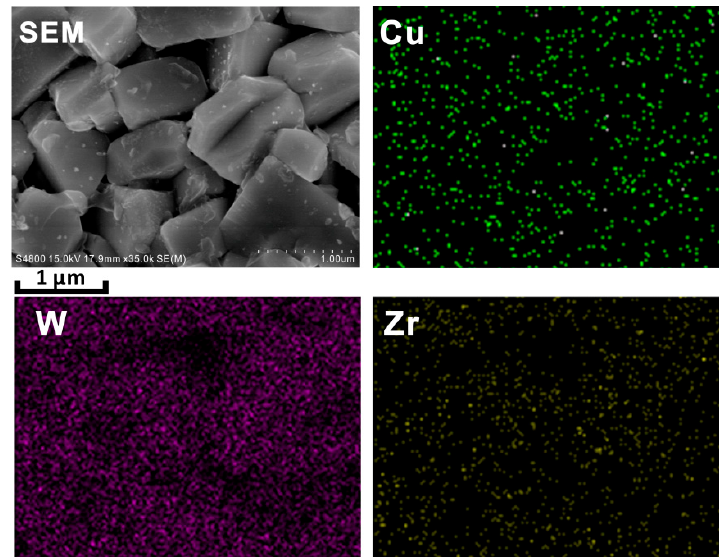
Figure 4. EDS element mappings of Cu, W, and Zr for the sample S3 fractured surface.